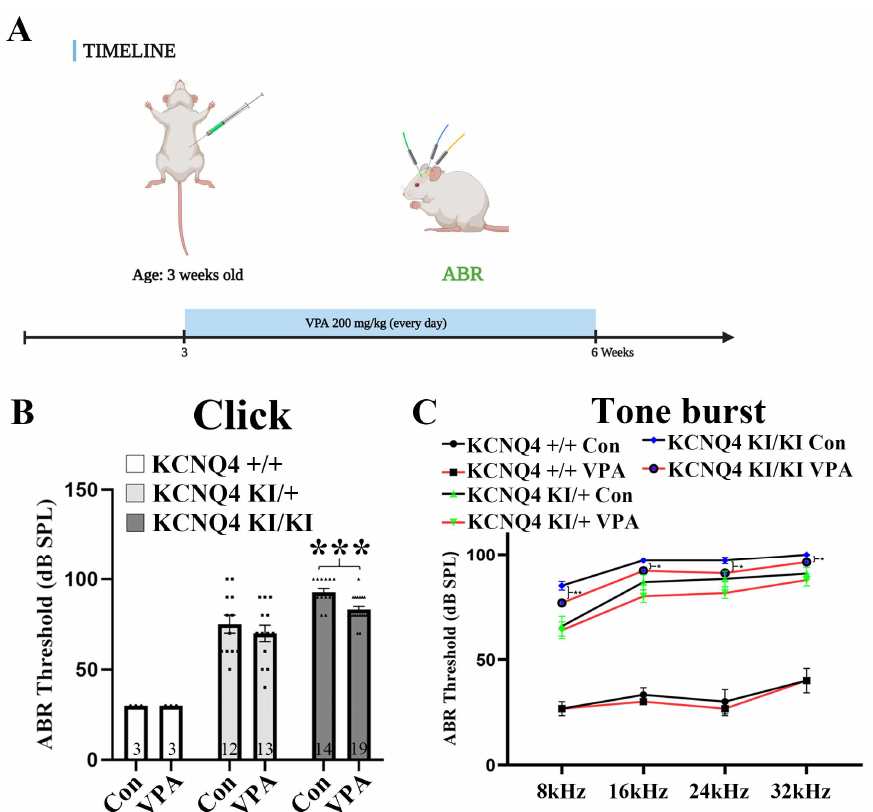
Figure 1. Systemic injection of VPA reduces hearing loss in the KCNQ4 p.W276S variant. ( A ) Experimental timeline. VPA was injected intraperitoneally into the WT, hetero KCNQ4 p.W276S variant, and homo KCNQ4 p.W276S variant mice. Three weeks later, the auditory brainstem response (ABR) was evaluated using click and tone burst stimuli. ( B ) VPA attenuated KCNQ4 p.W276S variant-induced hearing loss as shown by ABR click results. *** p < 0.001, numerals in bar graphs are the numbers of samples. Error bars represent S.E.M (standard error of the mean). Con: control; VPA: valproic acid. ( C ) The tone burst results showed a significantly decreased at 8, 16, 24, and 32 kHz in VPA homo KCNQ4 treated mice. * p < 0.05, ** p < 0.01, error bars represent S.E.M.